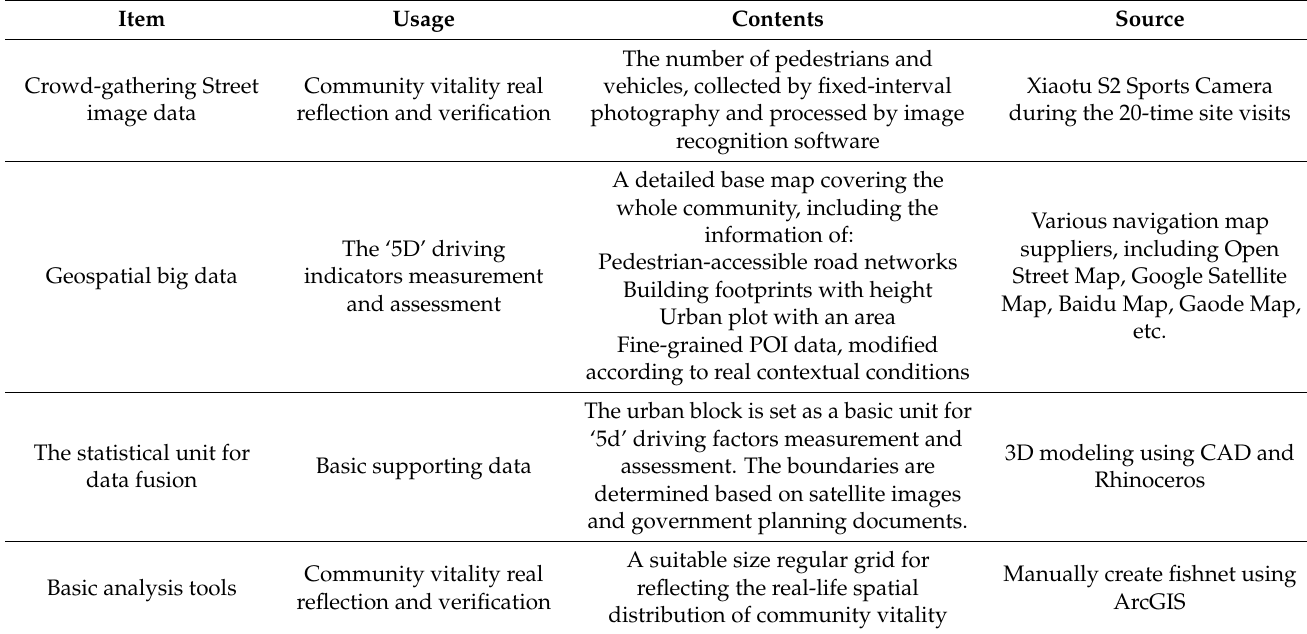
Table 1. The input datasets used in this